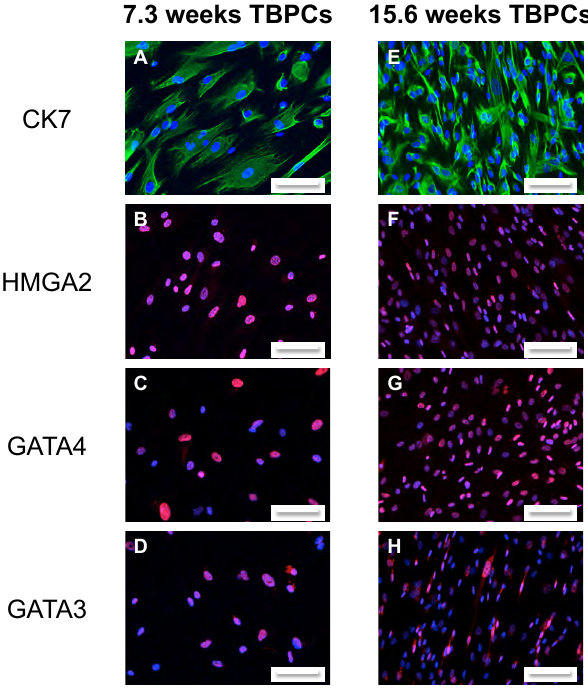
Figure 1. TBPCs express markers of trophoblasts and pluripotency. TBPCs from 7.3 weeks (left panel) and 15.6 weeks (right panel) of gestation were immunostained for CK7 ( A , E ), HMGA2 ( B , F ), GATA-4 ( C , G ) or GATA-3 ( D , H ). Nuclei were counterstained with DAPI. Scale bar = 100